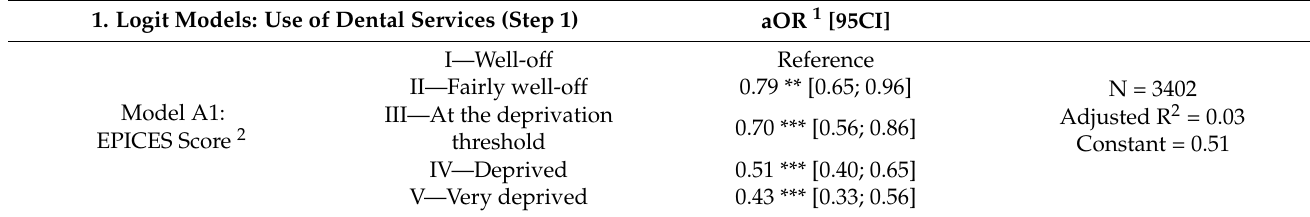
Table 3. Test for adjusted associations between each step of access to dental services and the en- abling